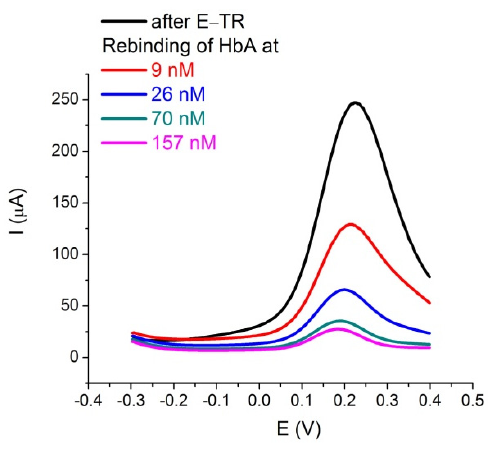
Figure 1. SWV responses of the hierarchical MIP recorded in a PBS solution at a pH of 7.4, containing 5 mM ferri/ferrocyanide and 10 mM KCl after electrochemical template removal (E-TR, black trace and after HbA rebinding using different protein concentrations (color code enclosed).